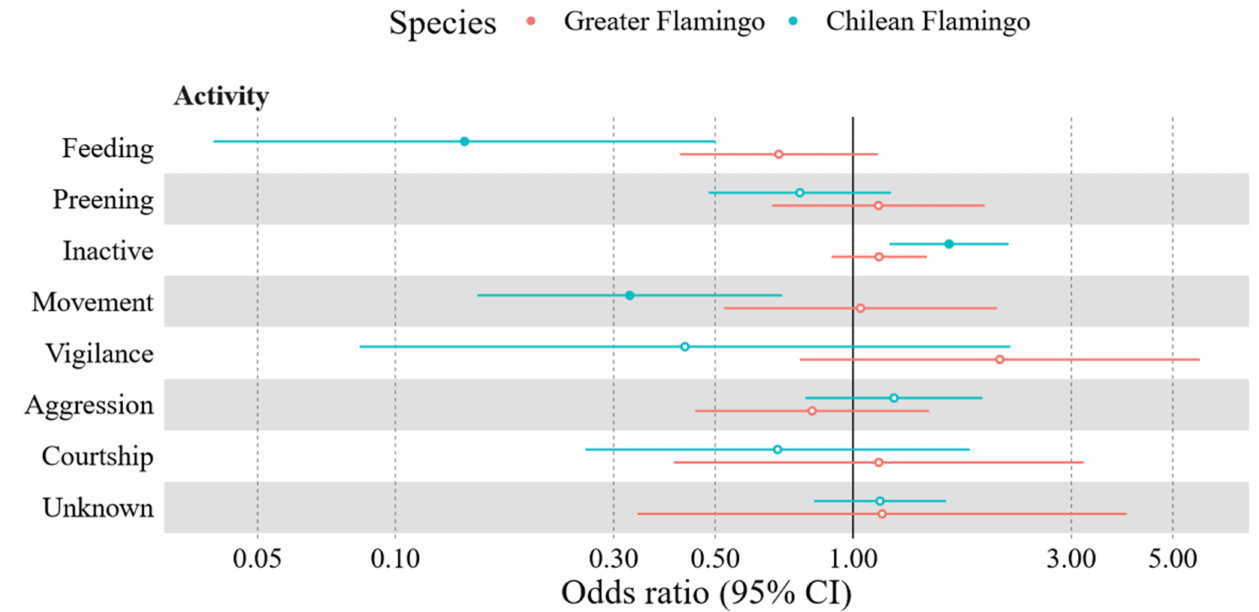
Figure 3. Odds ratios and 95% confidence intervals of the Greater and Chilean Flamingo flock to perform key behaviours when the zoos were open, compared to when the zoos were closed. Intercept = zoo closed. Hollow points = p ≥ 0.05; filled points = p < 0.05. The Greater Flamingos were just as likely to perform key behaviours when the zoo was open than when the zoo was closed. Compared to when the zoo was closed, Chilean Flamingos were 1.622 times more likely to be inactive, 0.142 times less likely to be feeding, and 0.325 times less likely to be moving when the zoo was